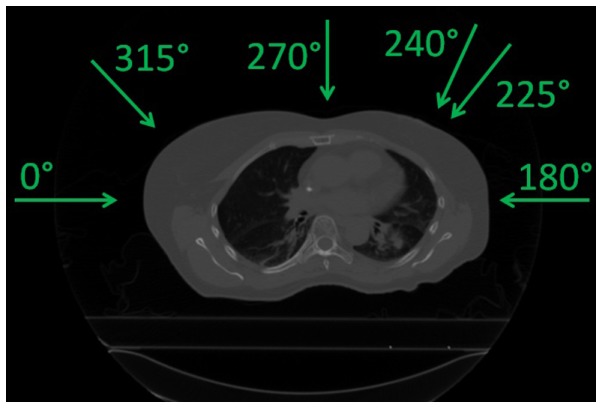
Field angles used (see Table 1).